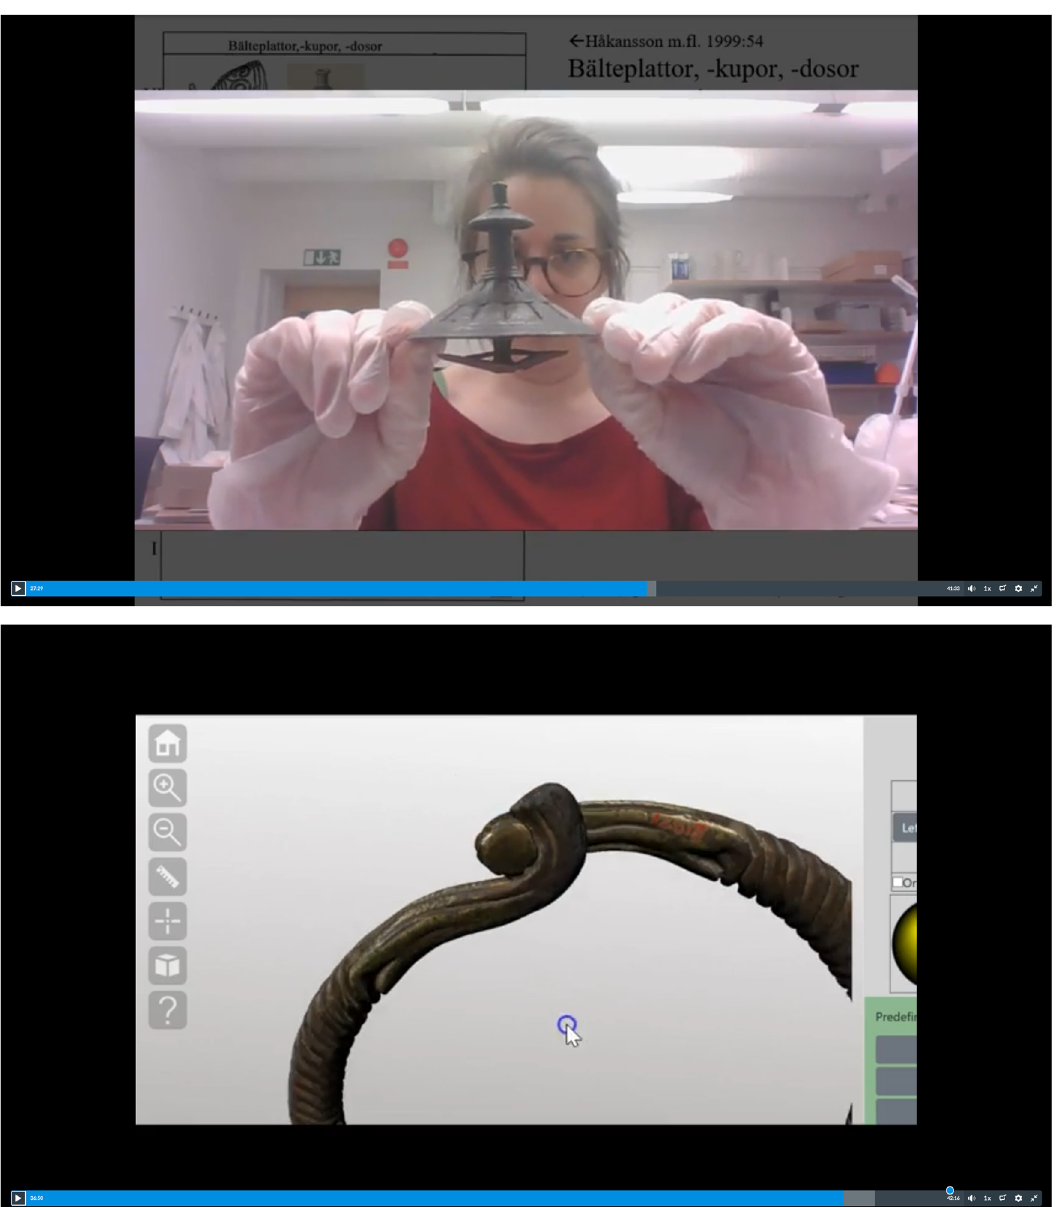
Figure 5: One of the teachers, Stella Macheridis, used prerecorded tutorials on Canvas – the online educational platform used by Lund University – to demonstrate the morphologies of Bronze Age